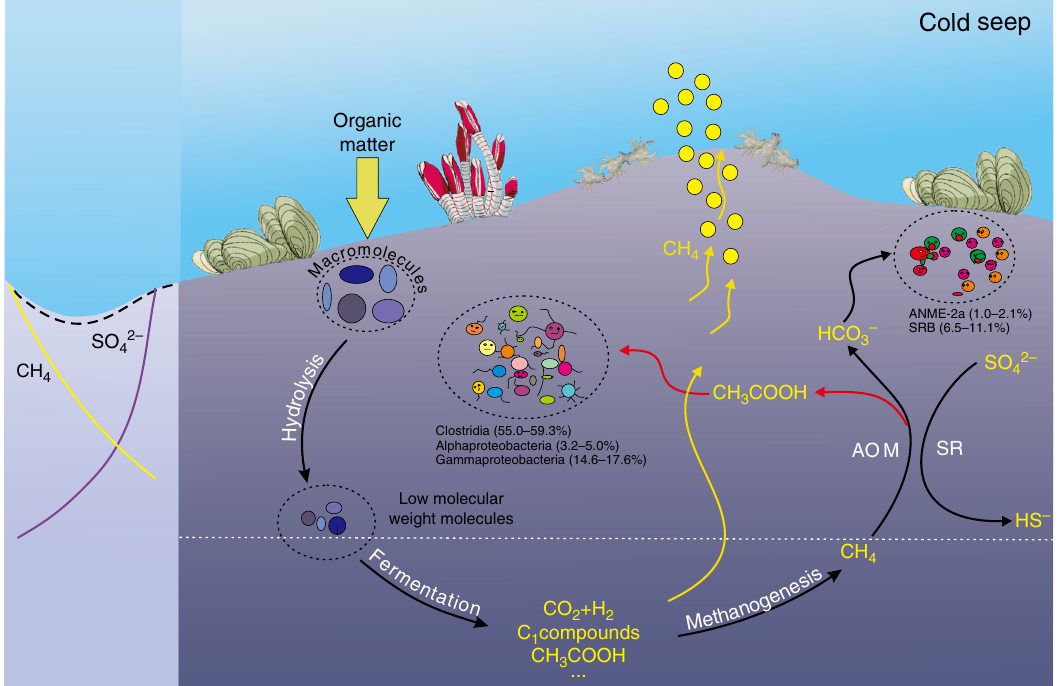
Fig. 6 Proposed conceptual diagram of carbon cycling in cold seeps. A proposed conceptual model of carbon cycling in cold seeps: during the classic anaerobic oxidation of methane process, methane can be converted into organic carbon, such as acetate, which further fuels the heterotrophic community in the